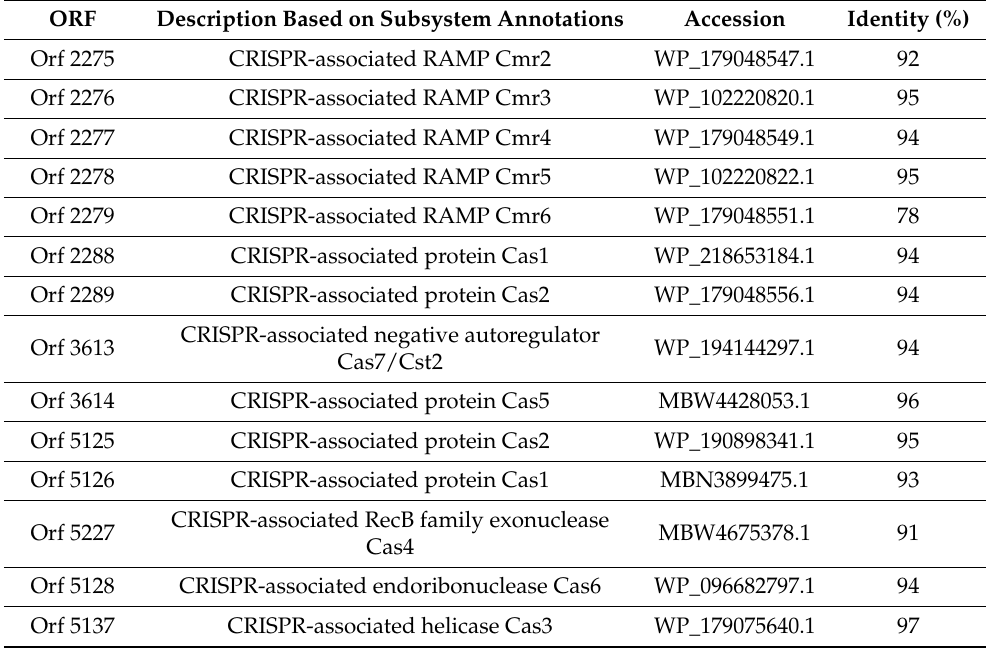
Table 2. Cyanocohniella sp. LLY open reading frame annotations and best Blast hit for CRISPR-CAS system